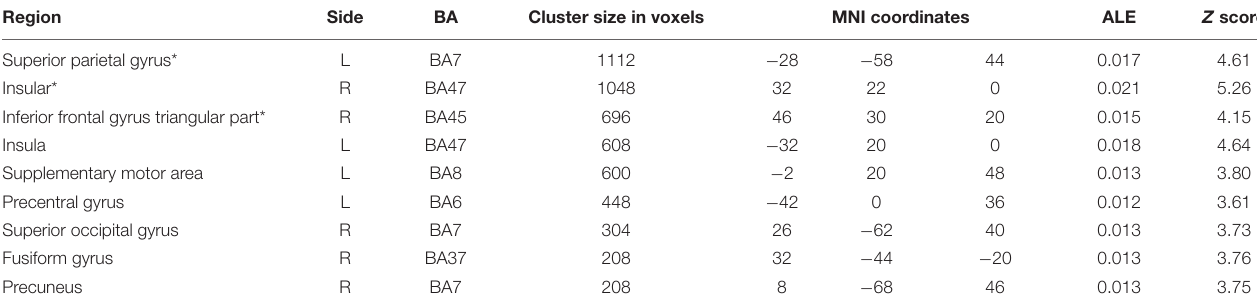
TABLE 2 | Unconscious activation greater than baseline.